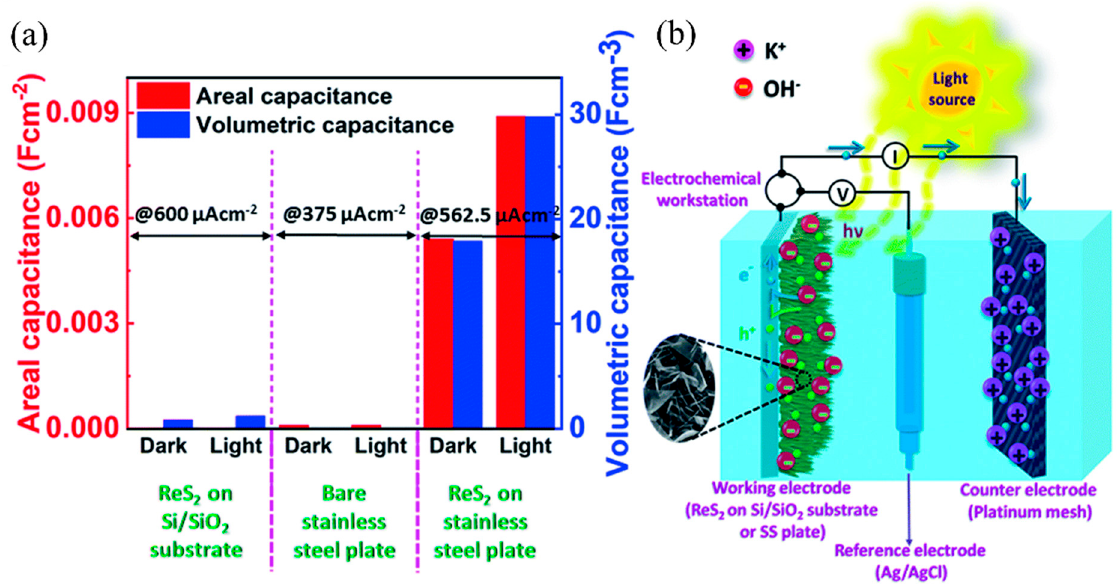
Figure 14. ( a ) The areal and volumetric capacitance of the supercapacitor under dark and light conditions. ( b ) Schematic illustration of the electron-hole pair generation under illumination. Reproduced from ref. [125] Copyright (2021) with permission from Royal Society of